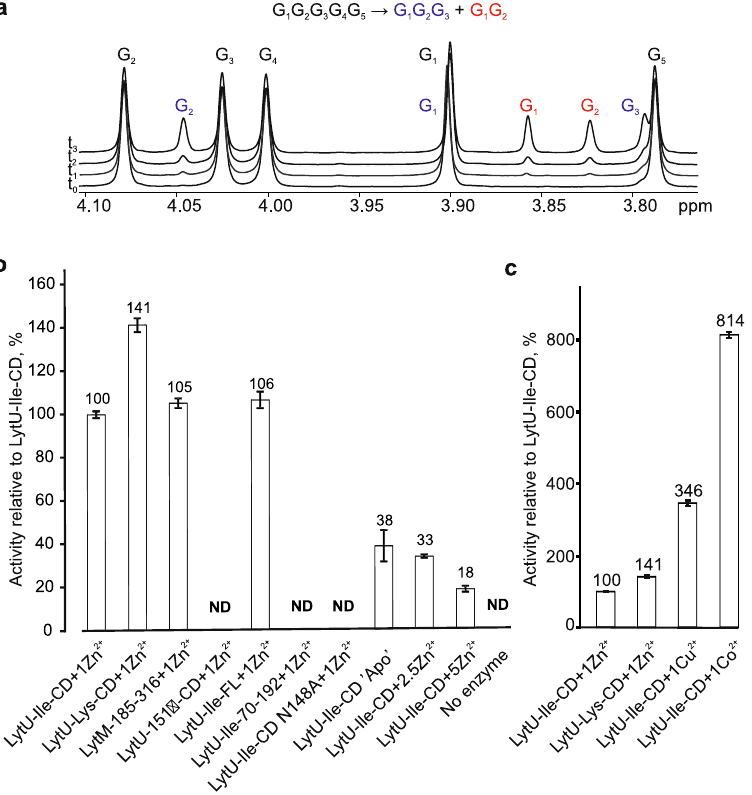
Figure 5. Catalytic activity. ( a ) Representative 1 H spectra of 2 mM pentaglycine in PBS buffer (pH 7.3, 90% D 2 O) before (t 0 ) and during the cleavage by LytU (t 1 –t 3 ). Pentaglycine is cleaved into tri- and diglycine. Substrate and product signals are labelled. Pentaglycine and product G1 signals overlap. Integration of product signals as a percent of TSP standard (not shown) allows to monitor and quantify the reaction rate. (b and c) Relative activity of proteins as a percentage of the activity of one zinc-bound catalytic domain of LytU-Ile. Reactions were linear for up to 70 hours. CD, catalytic domain, FL, full-length, ND, not detected. The bars represent standard error (SEM) of at least two independent